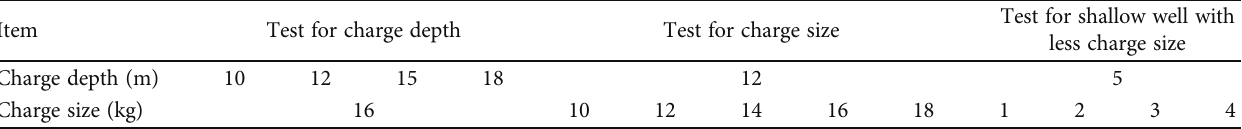
Table 2: Di ff erent charge depths and charge sizes in exciting test.